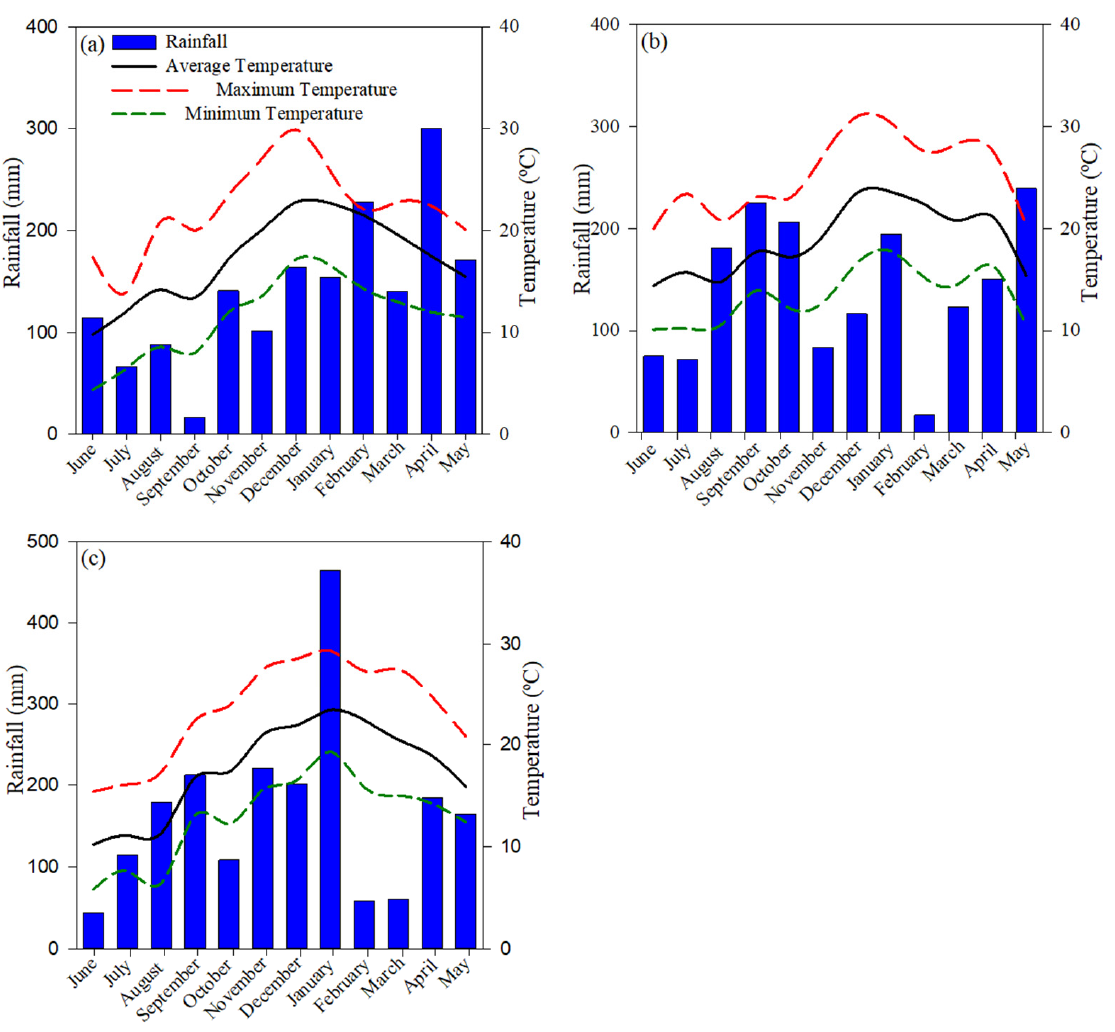
Figure 1. Monthly accumulated rainfall; minimum, average, and maximum air temperatures in the 2016/17 ( a ), 2017/18 ( b ), and 2018/19 ( c ) growing seasons, in the experimental vineyard, Santana do Livramento, Rio Grande do Sul state, Brazil.